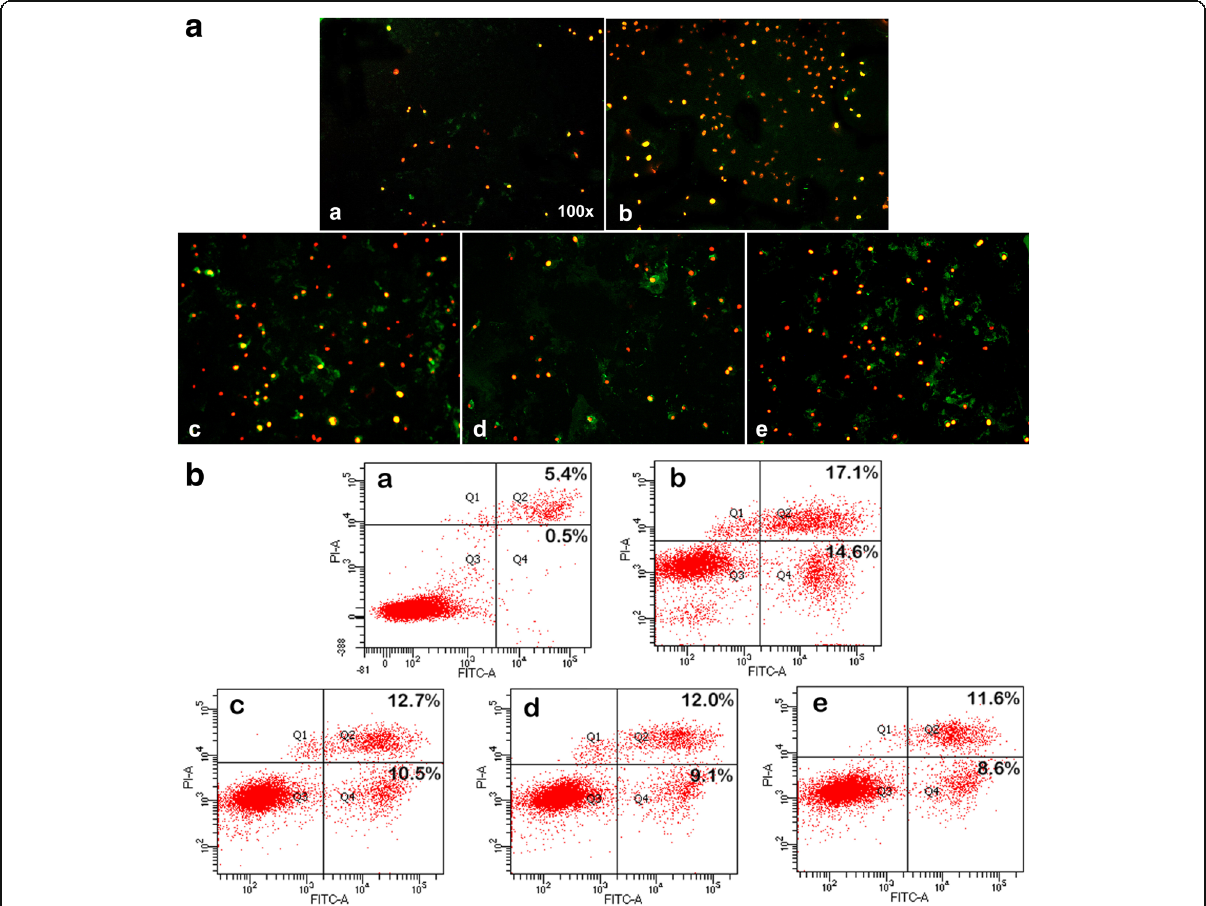
Fig. 6 Apoptosis of mitoxantrone and nanodrugs at 24 h on MB49 bladder cancer cells( a DMSO, b mitoxantrone, c CHP-3, d CHP-2, e CHP-1): A. Annexin V-FITC/PI double staining was detected by fluorescence microscopy, early apoptotic cells showed Annexin V-FITC – positive staining (green), necrotic cells were PI-positive (red), and late apoptotic cells showed positive double staining (yellow). B. Apoptotic rate was determined by FCM. Live cell (Q3), early apoptotic rate (Q4), late apoptotic rate (Q2), necrotic cells (Q1).The greater the cell staining, the higher the apoptotic